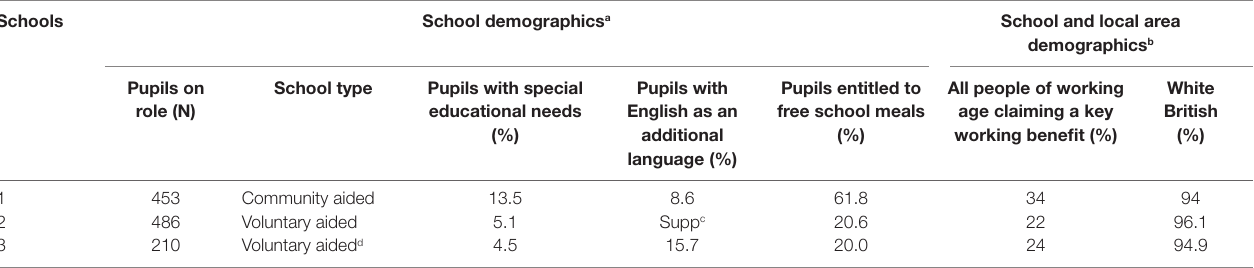
Table 1 | school characteristics and school area